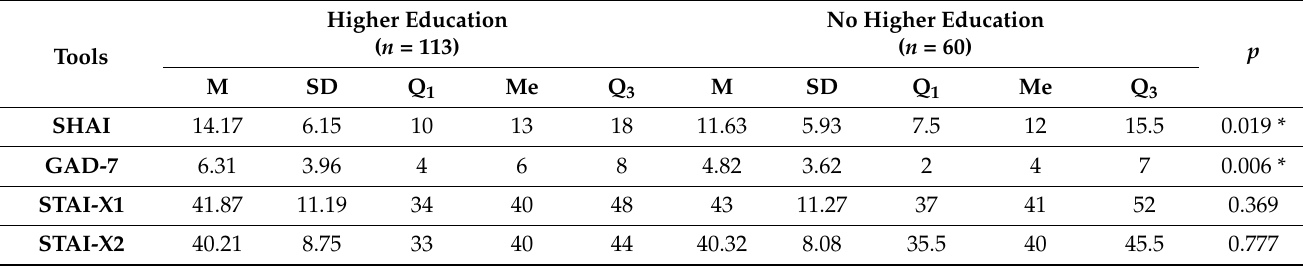
Table 4. Comparison of women with and without higher education for the following tools: SHAI, GAD-7, and STAI.